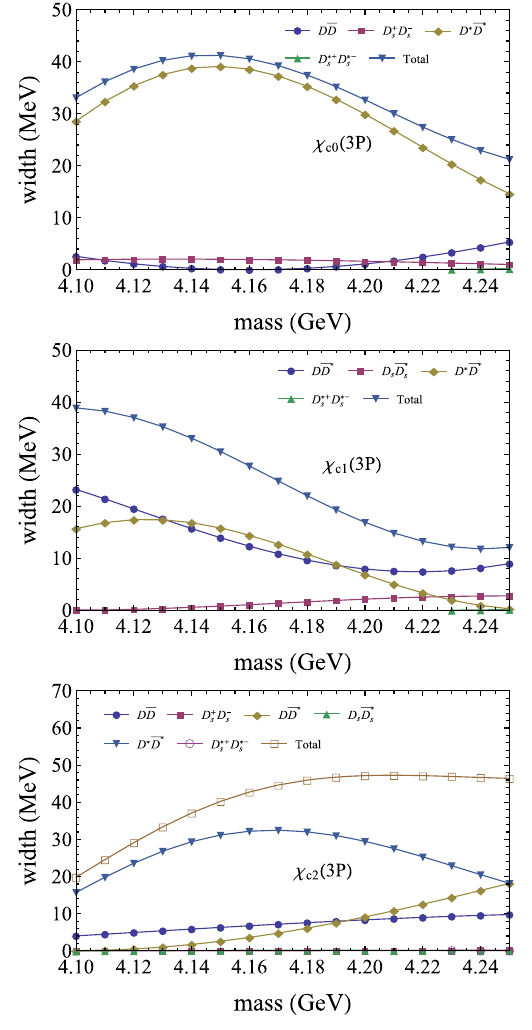
Fig. 3 The dependences of the widths of χ c 0 ( 3 P ) , χ c 1 ( 3 P ) and χ ( 3 P ) on the initial state mass with the wave function of Case c 2